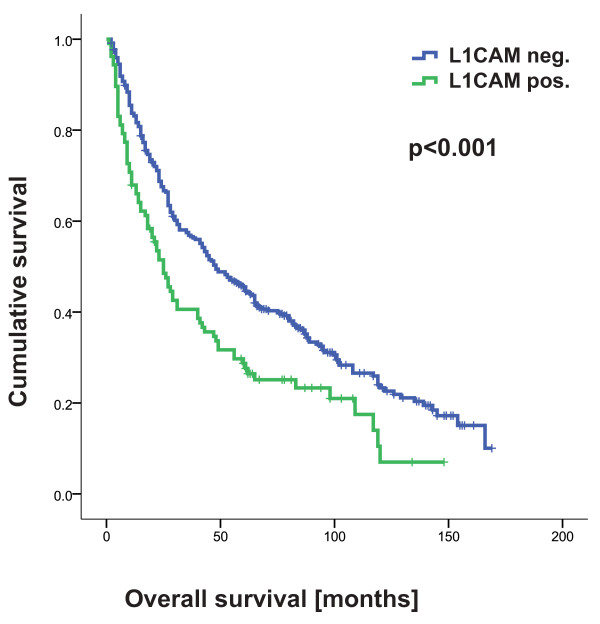
L1CAM expression is correlated with shortened overall survival.